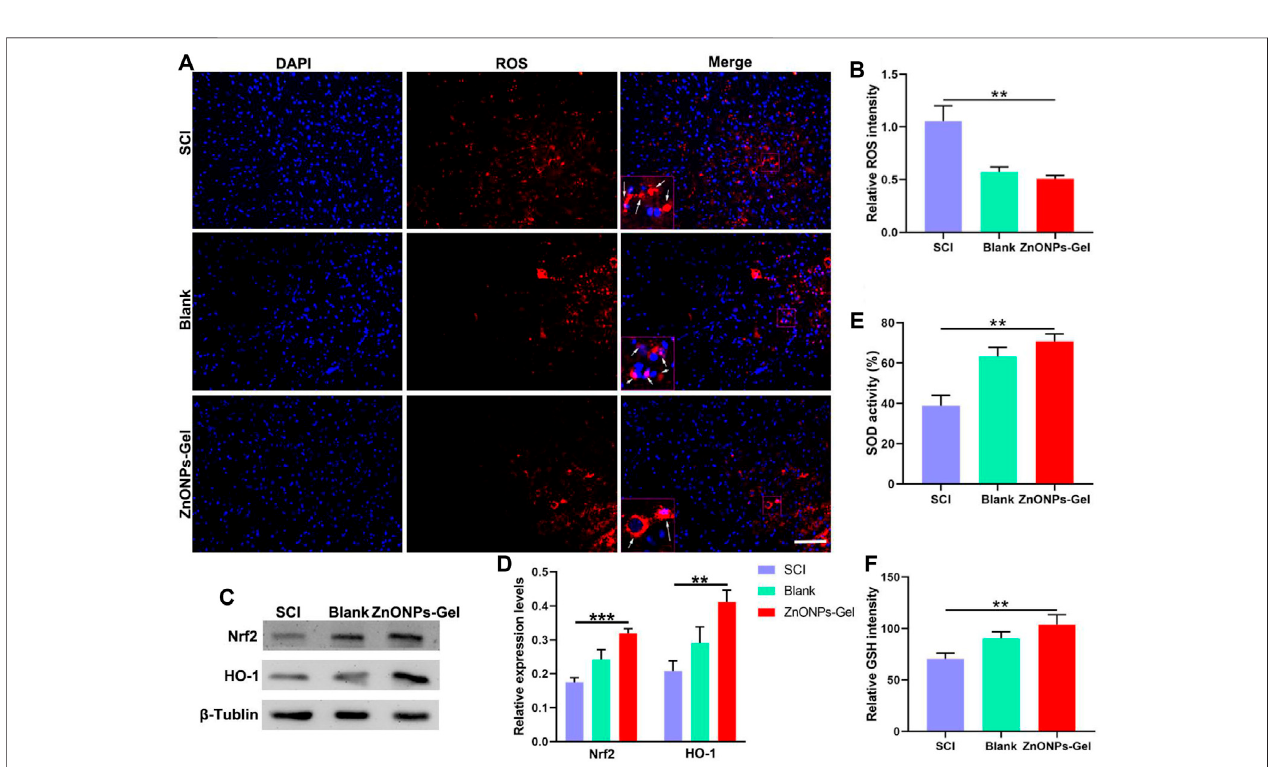
FIGURE 5 | ZnONPs-Gel inhibited injured spinal cord oxidation on days 28 after SCI. Representative images (A) and quanti fi cation (B) showing DAPI (blue) and ROS(red)staininginthelesionofSCI,blank,andZnONPs-Gel groups.Representativeimages (C) andquanti fi cation (D) oftheexpressionofNrf2andHO-1inthespinal cord of Sham, SCI, blank, and ZnONPs-Gel groups. Representative quanti fi cation showing SOD activity (E) and GSH (F) assays in the injured spinal cord of SCI, blank, and ZnONPs-Gel groups. Scale bar (cid:2) 100 μ m. Data are mean ± SD ( n (cid:2) 3).